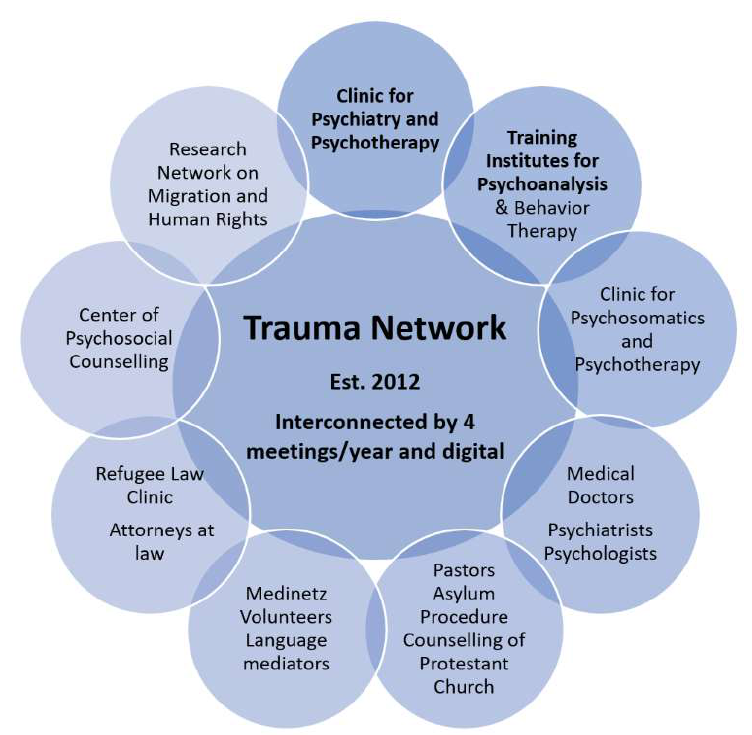
Figure 1. Actors in the trauma network in Middle Hesse for refugee care, hosts bolded. All actors are interconnected and support each other according to need within the framework with their specific competencies (e.g., supervision, legal advice, medical support and treatment, psychotherapy). To the best of our knowledge, there are superordinate umbrella organizations in Ger- many, some of which operate on a nationwide basis, which, for example, network indi- vidual psychosocial care centers with one another (e.g., The German Association of Psy- chosocial Centres for Refugees and Victims of Torture (BAfF), https://www.baff-zen- tren.org/english/ (accessed on 10 September 2022)) and carry out public relations work. At the local level, however, we are not aware of any similarly differentiated and multi- professional participatory networks. 4. The Scientific Part: Research As described above, the Center for Psychiatry and Psychotherapy at the University of Giessen decided not only to promote and bundle regional activities in refugee treatment and care, but also to support, through research activities, the process of building up structures and treating refugees from the very beginning. In addition, the authors draw on the scientific expertise of various members of the network from various disciplines. To develop and promote suitable offers for refugees, first and foremost the demand must be determined and measures to identify those in need of help must be implemented. In this sense, the European Parliament and the European Council stipulation from 2013 (Eu- ropean Parliament, European Council, 2013) [51] made it obligatory for member states to provide appropriate medical care (including psychological care) to so-called vulnerable ref- ugees. In their classification, vulnerable refugees included infants, people with disabilities, pregnant women, people with severe physical illness or mental disorders, as well as people who experienced torture, rape, and other interpersonal (sexual) violence. However, the im- plementation of the directive has been inadequate so far. The Trauma-Network has taken up this topic and conducted funded/nonfunded projects and research studies.